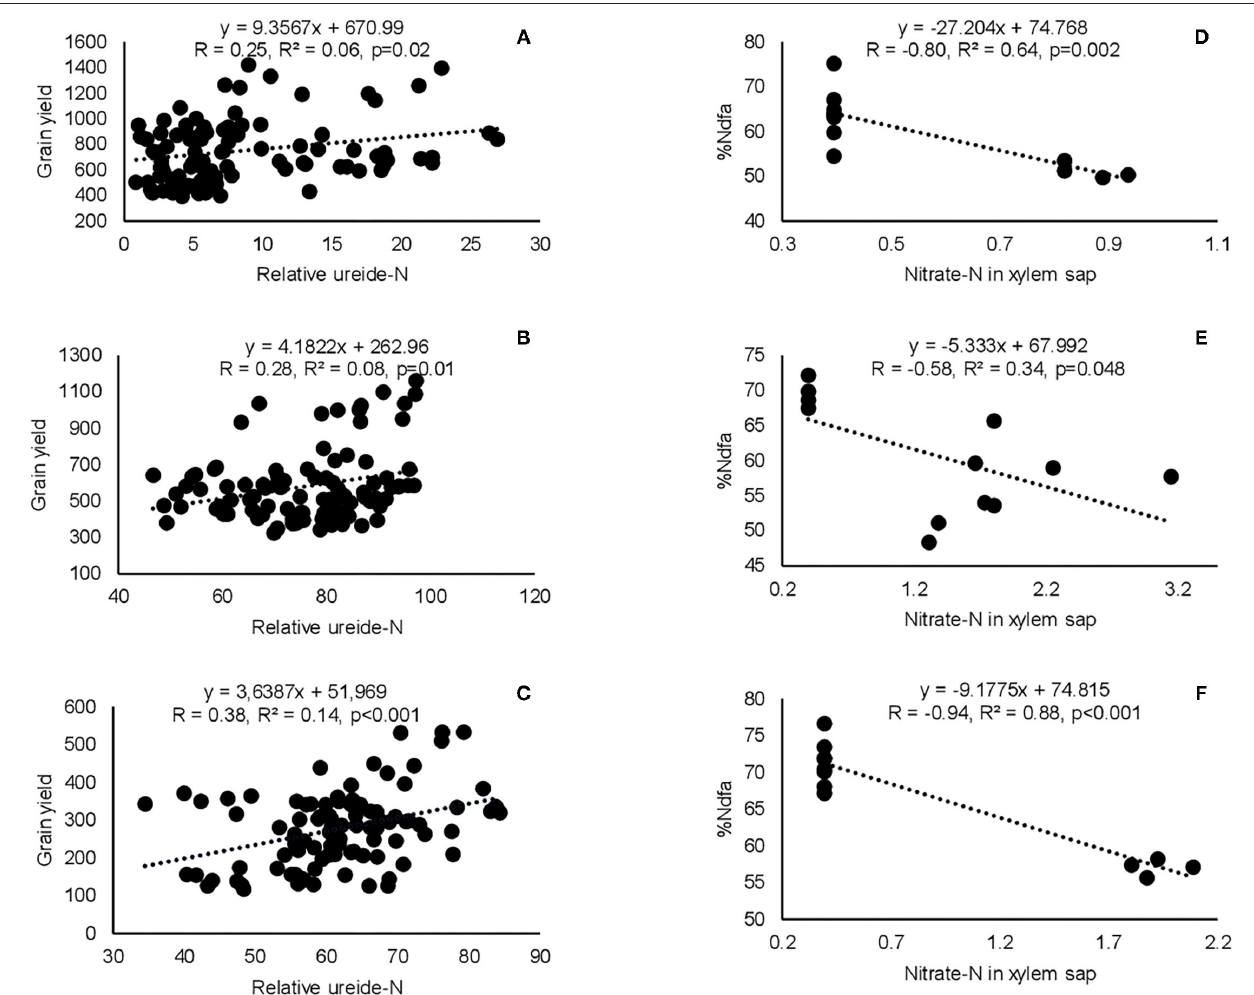
FIGURE 4 | Correlation and regression analysis between xylem nitrate-N and relative ureide-N (RU-N) and grain yield of eight Kersting’s groundnut landraces grown at (A) Nyankpala, (B) Savelugu, and (C) Gbalahi, and between xylem nitrate-N and %Ndfa from 15 N natural abundance in landraces (D) Boli, (E) Dowie, and (F) Funsi planted at Nyankpala in